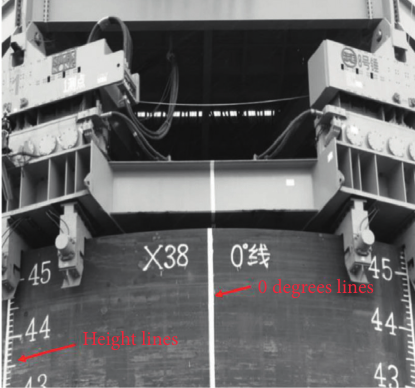
Figure 21: Scale lines in the steel cylinder.